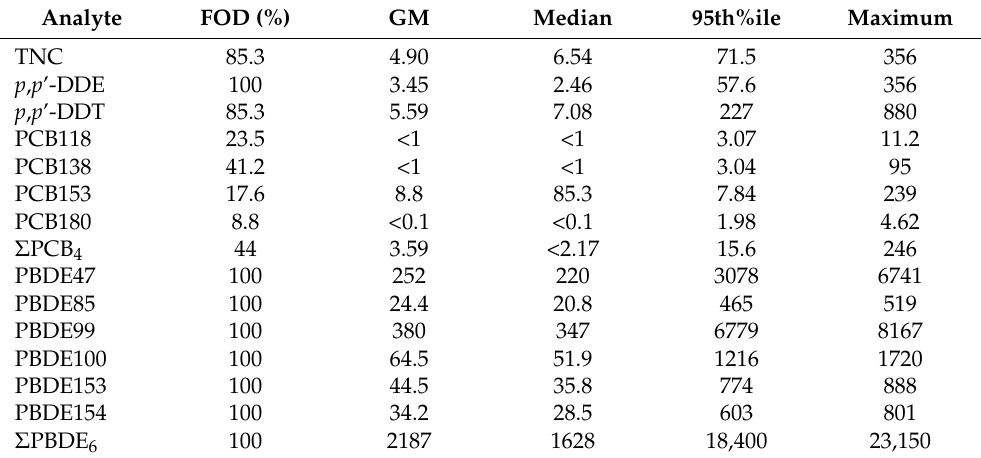
Table 3. Distribution of persistent organic pollutants in dust samples, Atlanta, 2016–2019